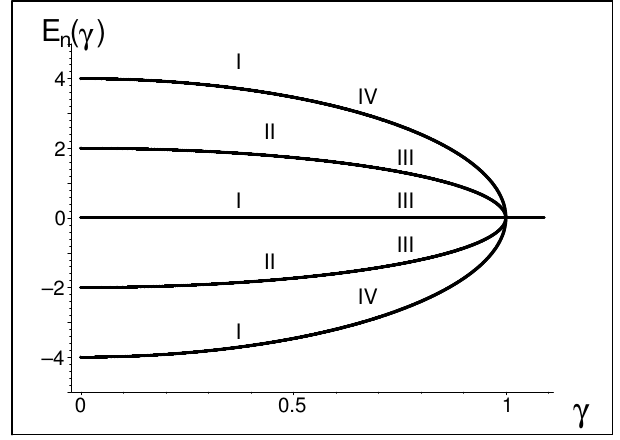
Figure 3. The BEC degeneracy (3) at N =